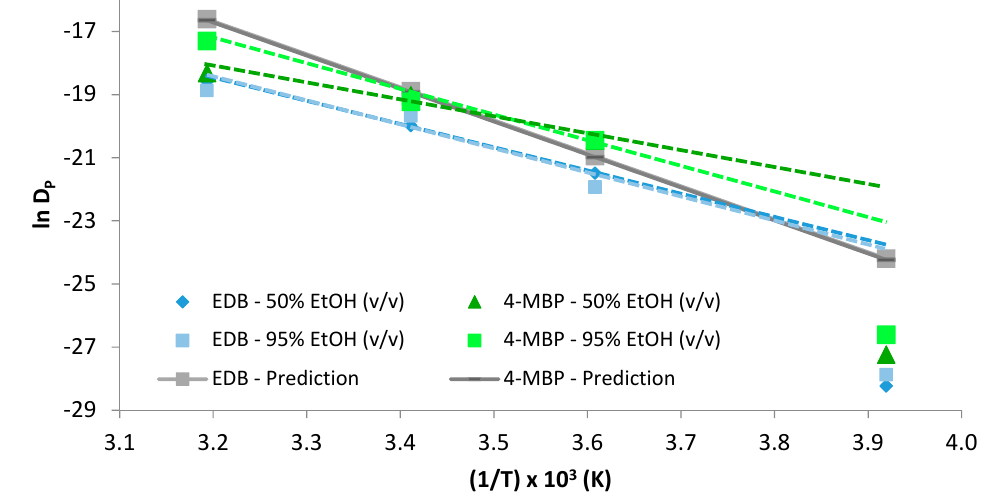
Figure 3. Application of the Arrhenius equation to estimate the relation between the obtained D P for ethyl-4-(dimethylamino) benzoate (EDB) and 4-methyl benzophenone (4-MBP) and the temperature. Dotted lines extrapolate the linearity estimated in the range 4–40 °C down to − 18 °C